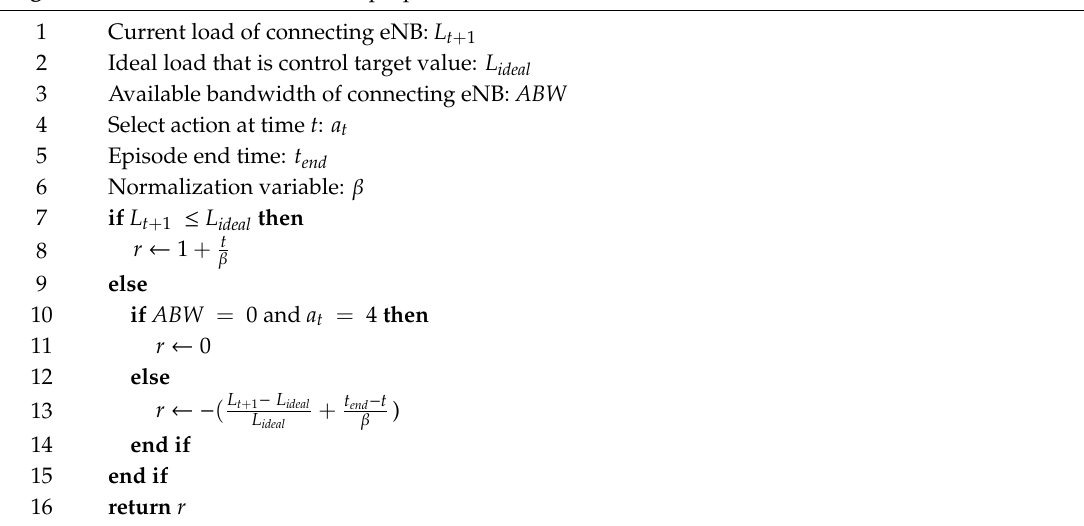
Algorithm 1 Reward function of the proposed